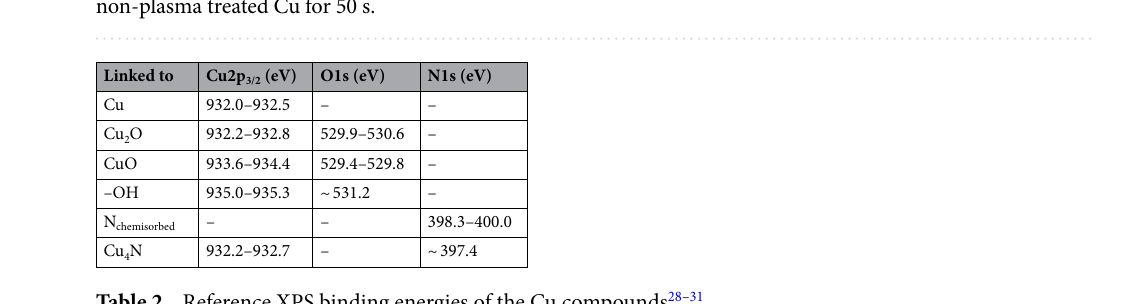
Figure 1. XPS analysis of Cu2p 3/2 , O1s, and N1s: ( a – c ) surface profiles of two-step Ar/N 2 plasma treated Cu and non-plasma treated Cu, ( d – f ) depth profiles of two-step Ar/N 2 plasma treated Cu and ( g – i ) depth profiles of non-plasma treated Cu for 50 s.